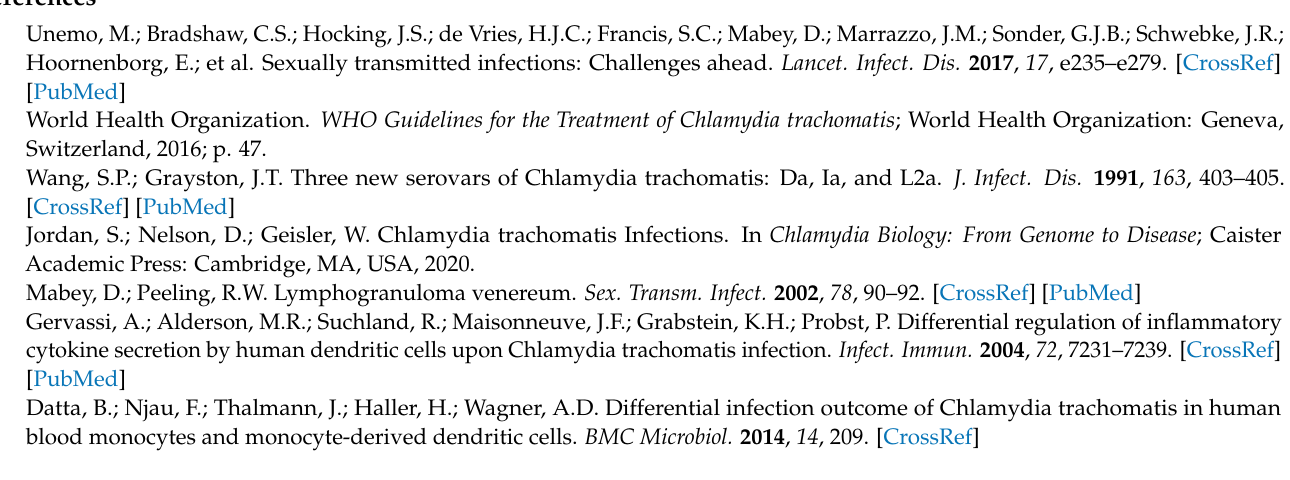
Figure S6: Discrimination of Ct inclusions versus spots by imaging flow